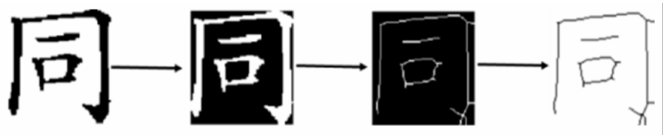
Figure 3. Skeleton extraction of a Chinese character “ 同 ” (means